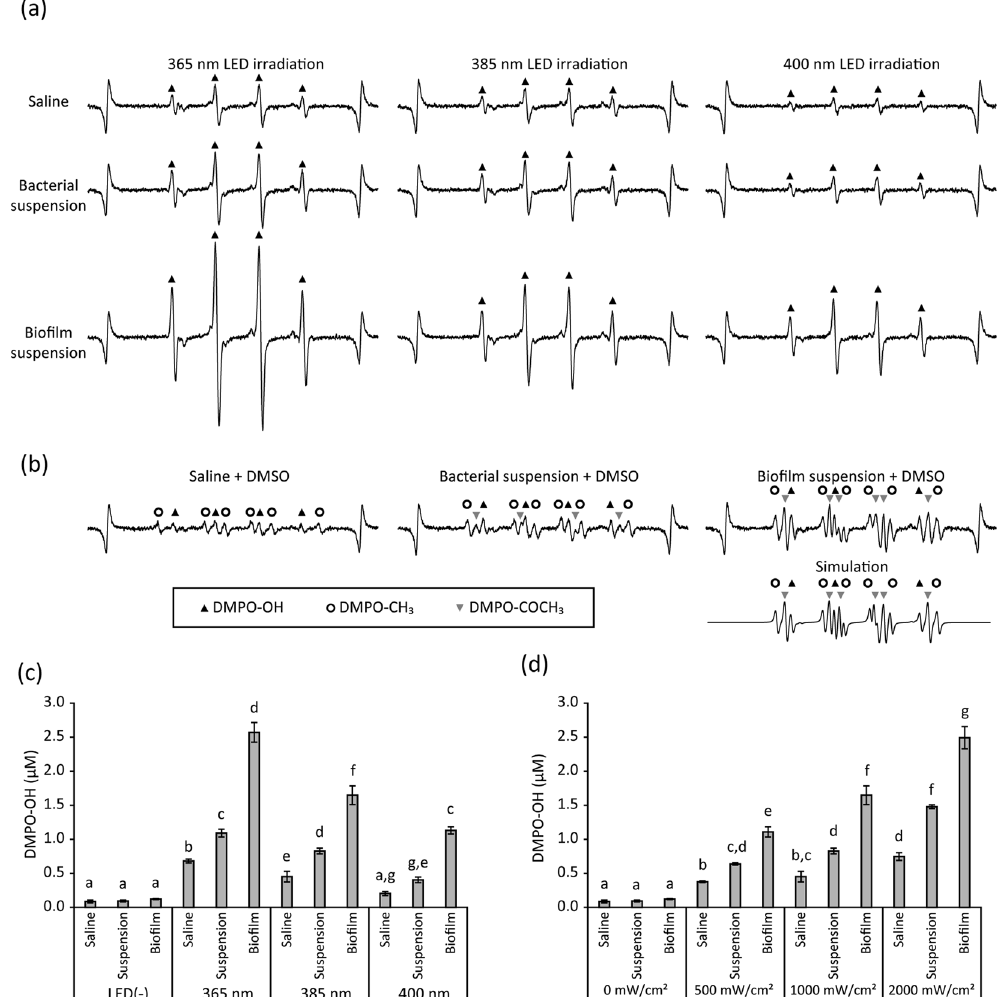
Figure 5. Analysis of hydroxyl radicals generated by LED irradiation of bacterial and biofilm suspensions. Hydroxyl radicals were qualitatively and quantitatively analysed using electron spin resonance (ESR)-spin trapping technique using 5,5-dimethyl-1-pyrroline N -oxide (DMPO) as a spin trap agent. ( a ) Representative ESR spectra of DMPO-OH (spin adduct of hydroxyl radical: closed triangle) generated using each condition (irradiance: 1000 mW/cm 2 , viable bacterial counts: 10 7 CFU/sample, treatment time: 1 min). The peaks at both ends represent Mn 2 + used as an internal standard. ( b ) Representative ESR spectra recorded when DMSO was added to the reaction system (365 nm LED irradiation of sample at 1000 mW/cm 2 ). DMPO-OH, DMPO-CH 3 (spin adduct of methyl radical: open circle) and DMPO-COCH 3 (spin adduct of acetyl radical: inverse triangle) were detected. Computer simulation was performed using hyper fine coupling constants described in the text. ( c ) Yield of DMPO-OH generated by the LED irradiation of samples at different wavelengths (irradiance: 1000 mW/cm 2 , treatment time: 1 min). ( d ) Yield of DMPO-OH generated by the LED irradiation of samples at different irradiances (wavelength: 385 nm, treatment time: 1 min). Values and error bars in ( c ) and ( d ) indicate the mean and standard deviation, respectively. Different letters above the columns in ( c ) and ( d ) refer to significant differences ( p < 0.05) between different